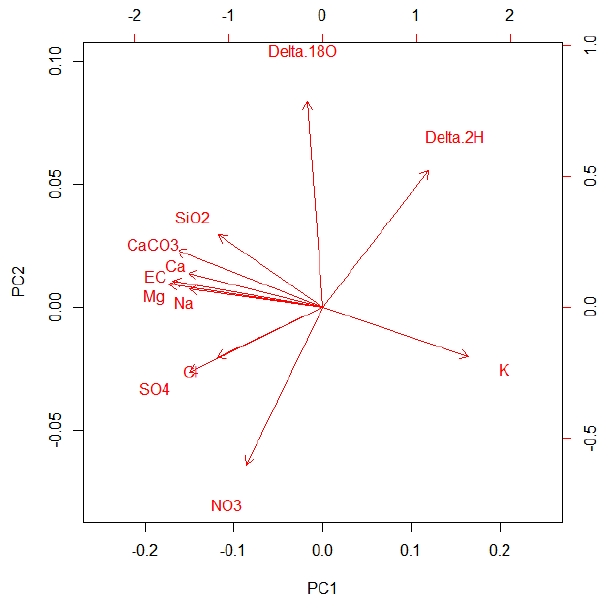
Figure 10. Biplot of principal components generated during PCA of streamwater samples using EC, SiO 2 , CaCO 3 , Cl, NO 3 –N, SO 4 , Na, Mg, K, Ca, δ 2 H, and δ 18 O.